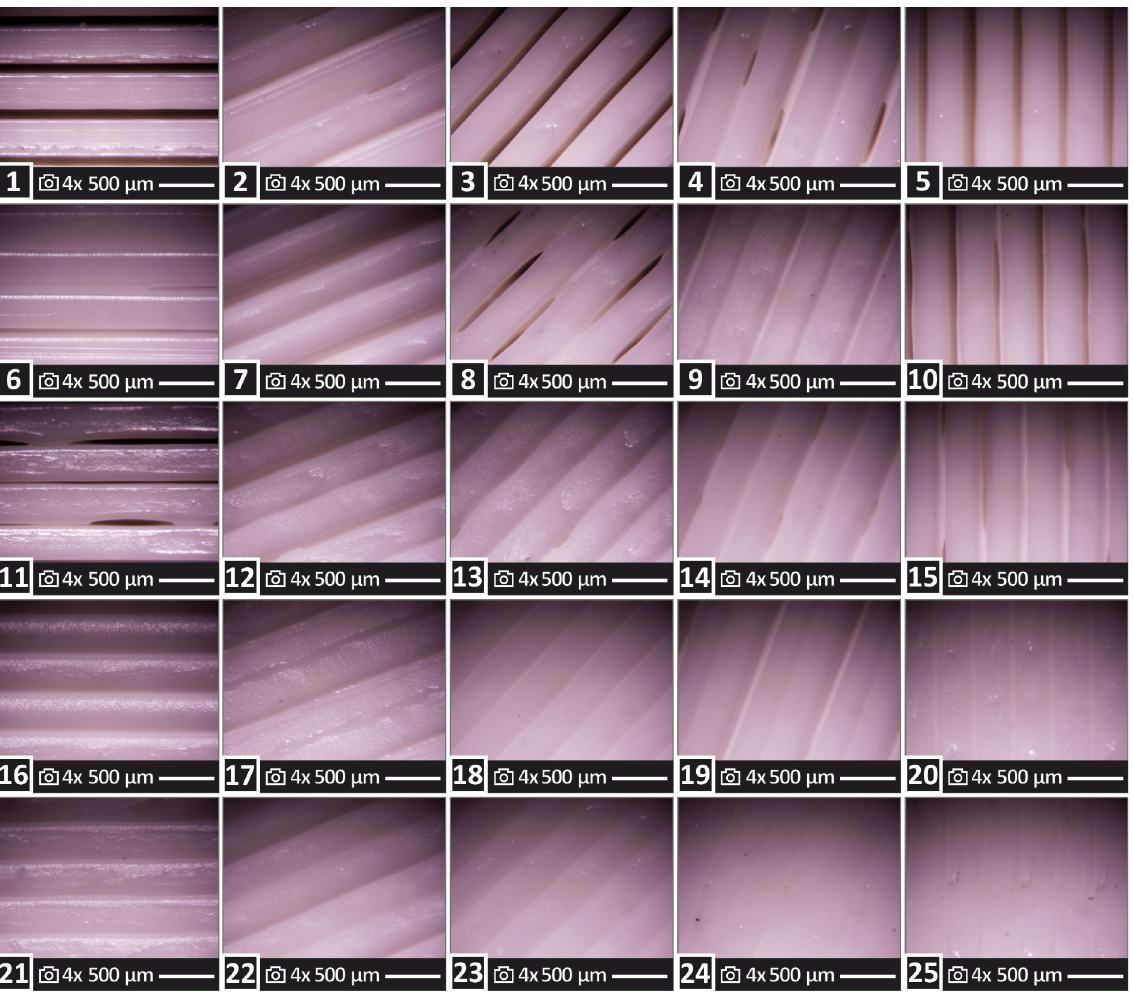
Figure 3. Optical stereoscope images are 4× magnification depicting the top surface on one of the five samples evaluated for each one of the twenty-five runs. The 3D printing structure differences among the samples can be evaluated in the images. In each image, the number corresponds to the run of the sample shown.